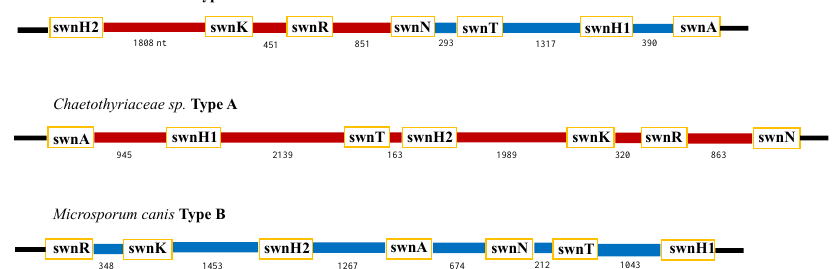
Figure 8. Intergenic region types map of three representative fungi. Intergenic regions colored red indicates type A combination (ex: swnH2-swnK in Chaetothyriaaceae) and intergenic regions colored blue indicates type B combination (ex: swnK–swnH2 in M. canis ). Metarhizium acridum contained both types A and B are labeled as A/B type. Chaetothyriaceae sp. only contained type A (A dominant), and Microsporum canis only contained type B (B dominant). Numbers under intergenic regions represent their size, nt =